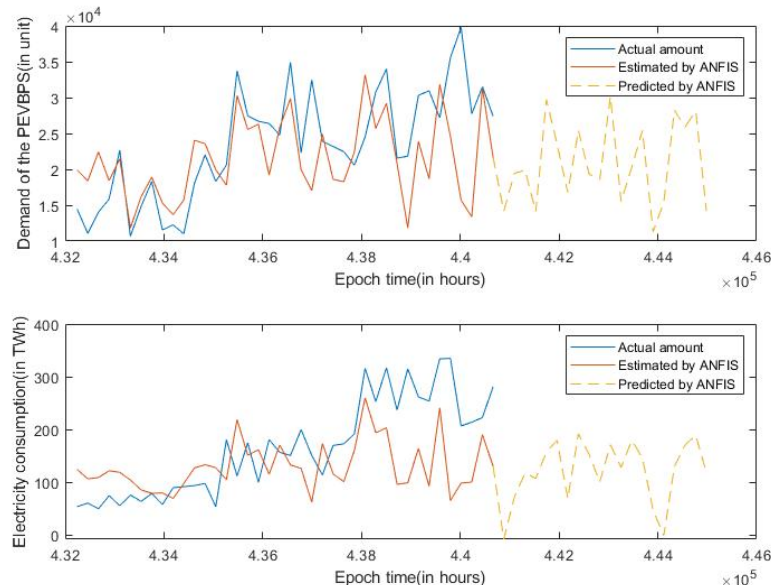
Figure 11. Figure 11. Battery life-cycle management for the plug-in electric vehicle battery pack standardization (PEVBPS).